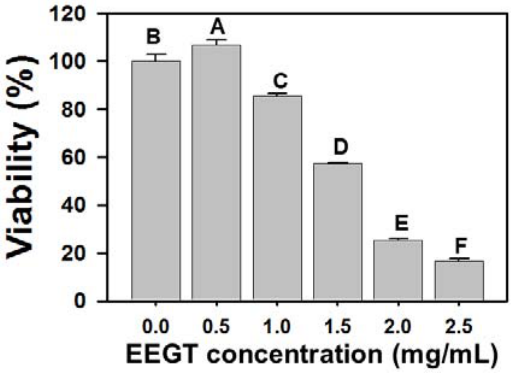
Figure 1. Proliferation of Ca9-22 oral cancer cells is inhibited by ethanolic extracts of G. tenuistipitata (EEGT). Cells were incubated with various concentrations of EEGT (0, 0.5, 1, 1.5, 2 and 2.5 mg/mL) for 24 h. Cell viability was determined by MTS assay. Data are expressed as mean ± S.D. (n = 6). Differences between treatments of different concentrations containing the same capital letter at the top of each column are not significant.